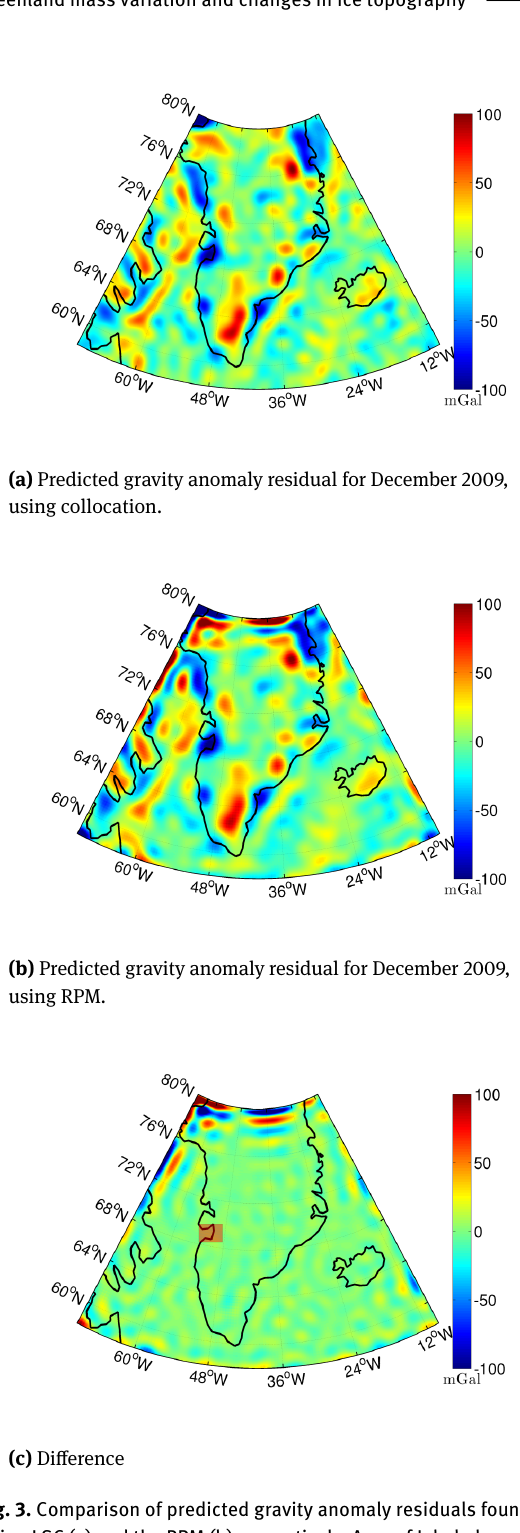
JI and the Helheim glacier as well as in the northwestern